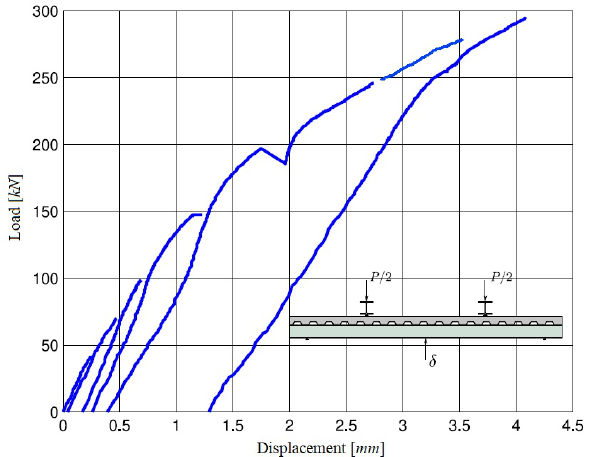
Figure 10. Load–displacement curve for composite steel–concrete